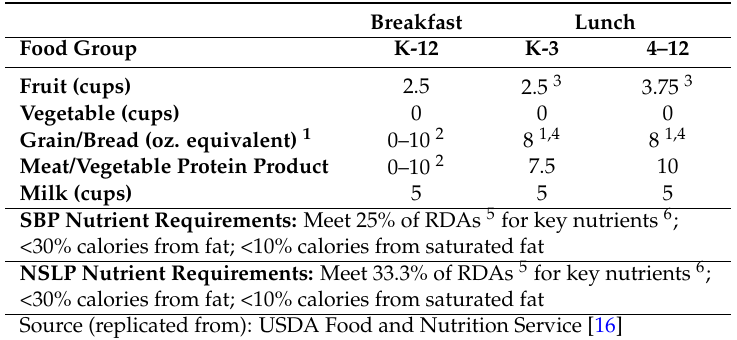
Table 3. An Overview of the 1994 School Breakfast Program (SBP) and National School Lunch Program (NSLP) Weekly Nutrition Standards.